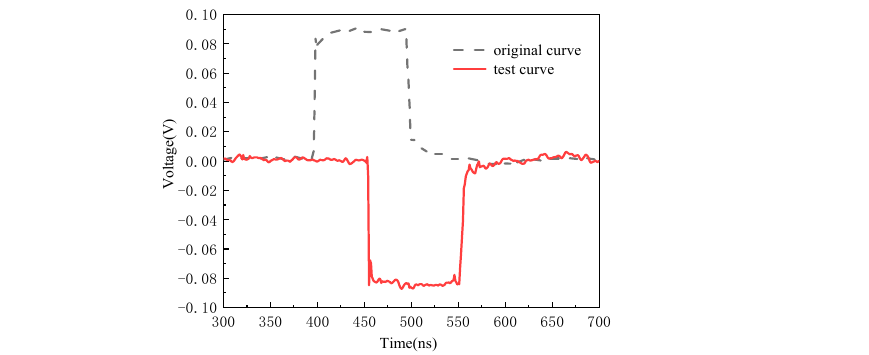
Figure 13. The time domain test configuration diagram of the weak field strength test ( a ) and strong field strength test ( b ).